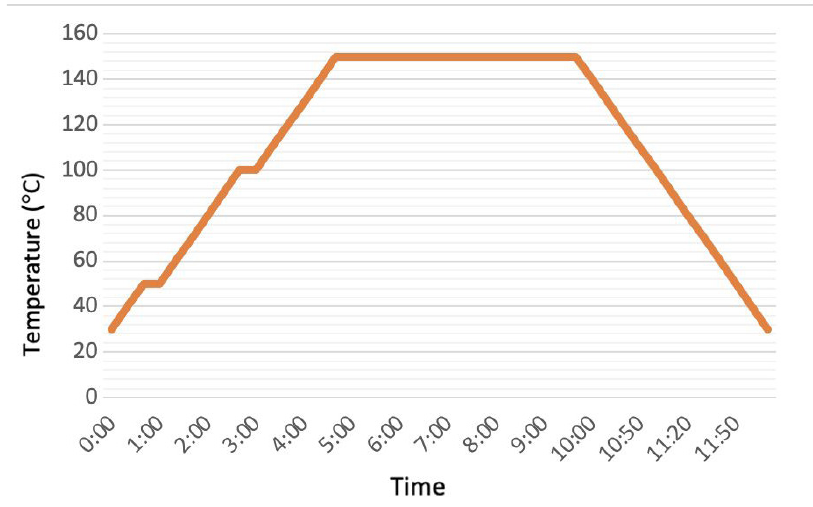
Figure 2. Sintering parameters of selective surface using a resistive kiln.